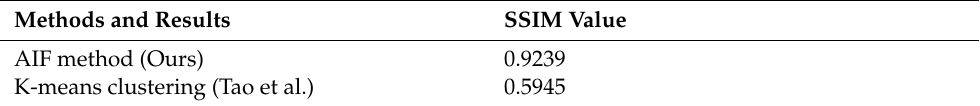
Table 2. SSIM results of the coating layer with different reconstruction methods.